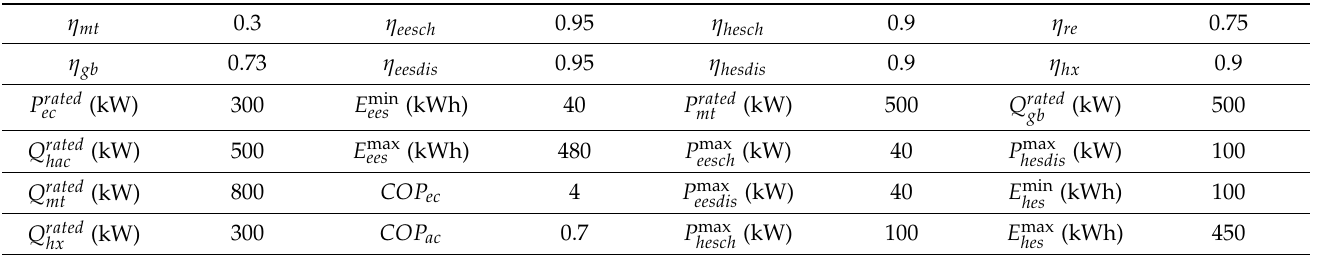
Table 7. Parameters of EV charging and discharging .